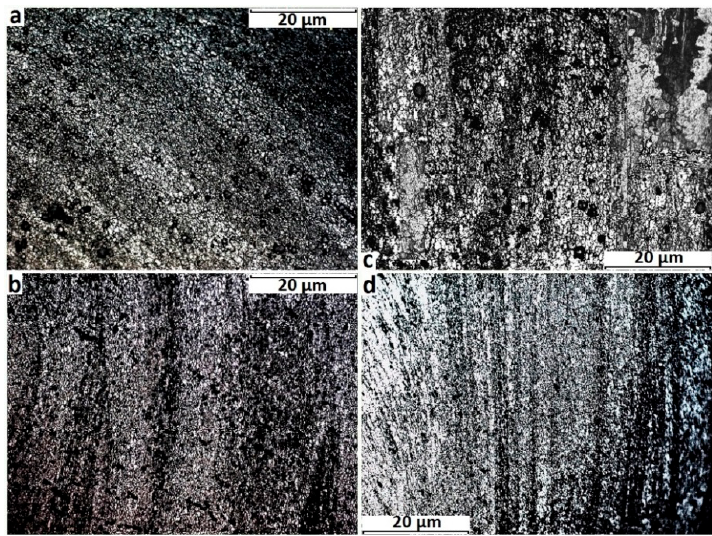
Figure 8. Morphological transition of grain flow in the TMAZ processed by etchant F: ( a ) top shoulder-A.S; ( b ) bottom shoulder-A.S; ( c ) top shoulder-R.S; and ( d ) bottom shoulder-R.S.